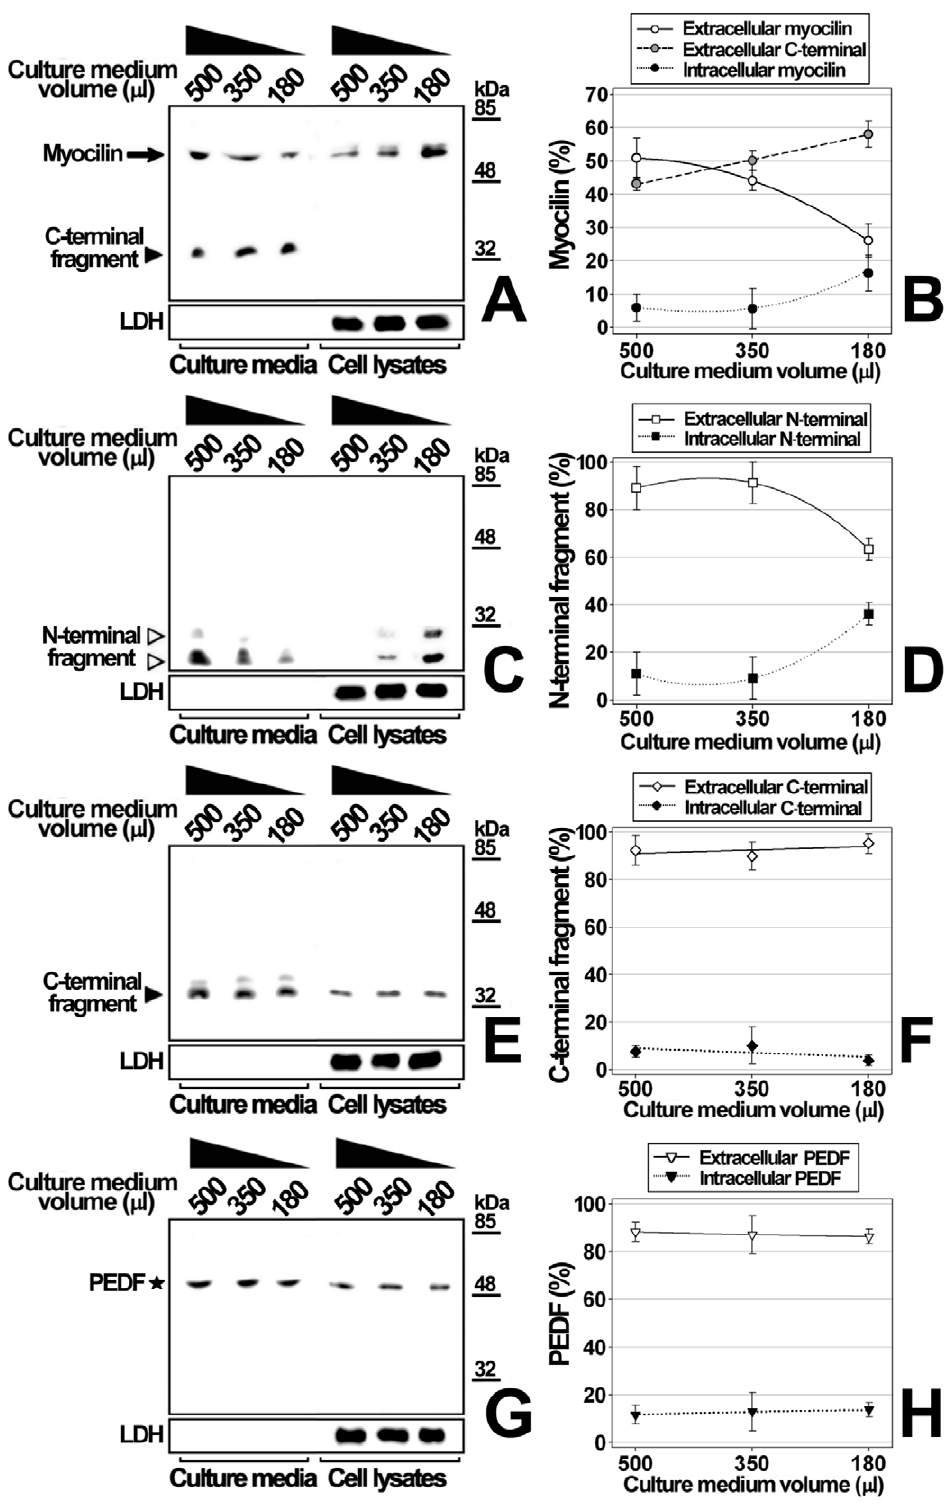
Figure 12. Identification of the myocilin region involved in its intracellular accumulation in response to extracellular bicarbonate- depletion. HEK-293T cells (400000 cells/plate in 24-well plates) were transfected with cDNA constructs encoding full-length myocilin (A), a myocilin N-terminal fragment (amino acids 1–226) (C), a myocilin C-terminal fragment (amino acids 217–504) (E) or the control protein PEDF (G). All the recombinant proteins were fused to the myc epitope on their C-terminal ends. After transfection, cells were incubated for 48 h in 3 different culture medium volumes (500, 350 and 180 ul). Extracellular and intracellular recombinant proteins were analyzed in aliquots representing 5% of either the total culture medium volume or cell lysate, by 10% polyacrylamide SDS-PAGE and Western blot using an anti-myc monoclonal antibody. As an